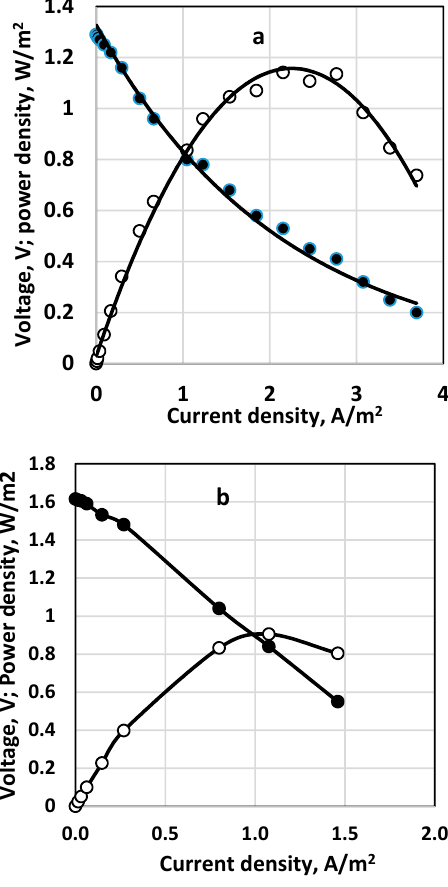
Figure 15. Polarization curves and power density for two types of fuel cell organization. ( a ) two parallely coupled fuel cells as a stack; ( b ) two consecutively coupled fuel cells. Continuous process. Membrane Celgard 3501. Active membrane and electrode area—650 sq. cm. Inlet sulfide concentration 236 g dm − 3 . Supporting electrolyte—16 g dm − 3 . Feed flow rate—0.4 dm 3 /h for each of the parallel cells ( a ) and for the consecutively coupled ones ( b ). Anode volume 800 cm 3 for each cell. Temperature 20 °C. (•)—cell voltage; ( ○ ) power density.